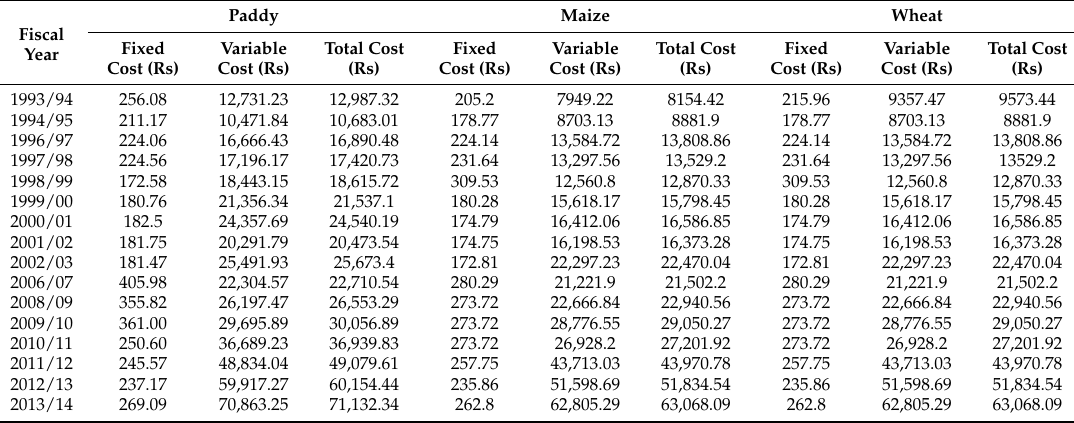
Table 15. Data on average production cost of major crops for the last 20 years, generated from [29]. Fiscal